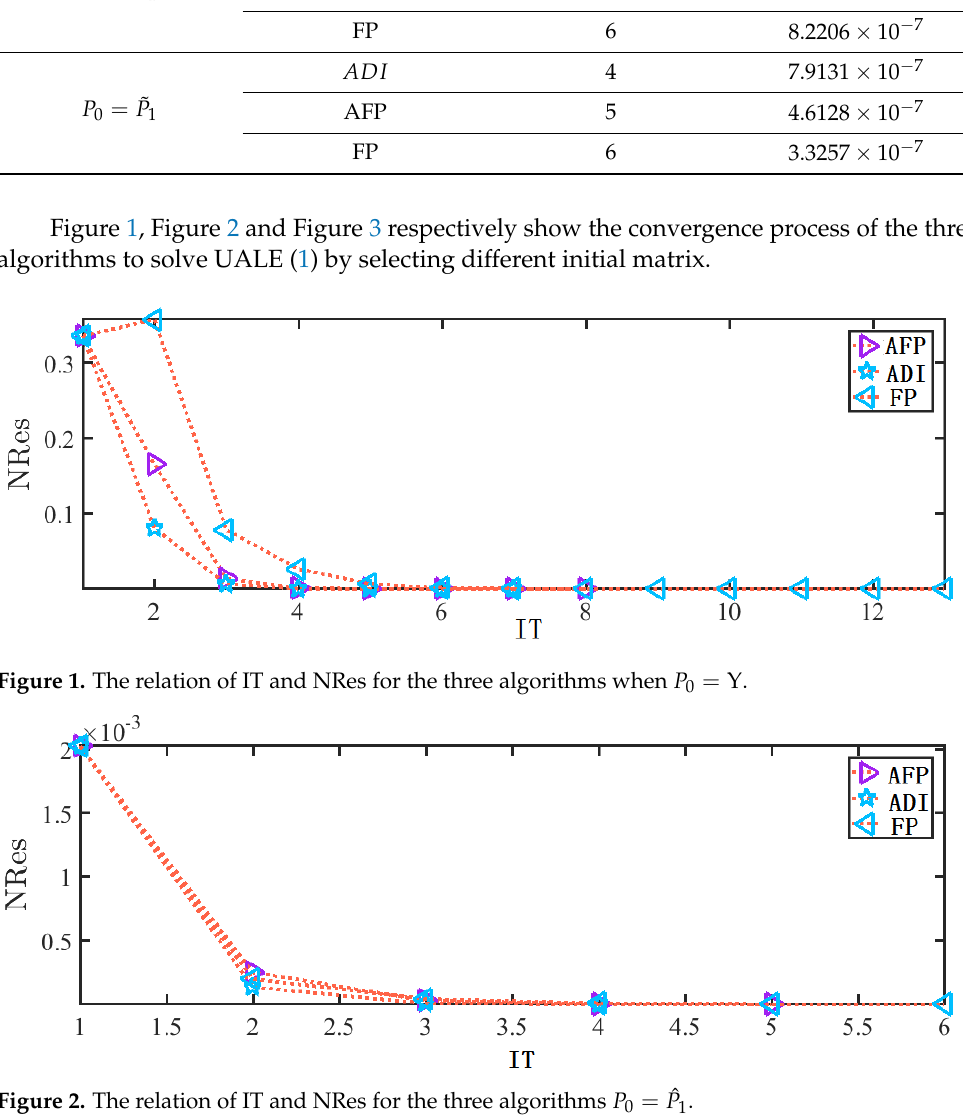
Figure 2. The relation of IT and NRes for the three algorithms P 0 = ˆ P 1